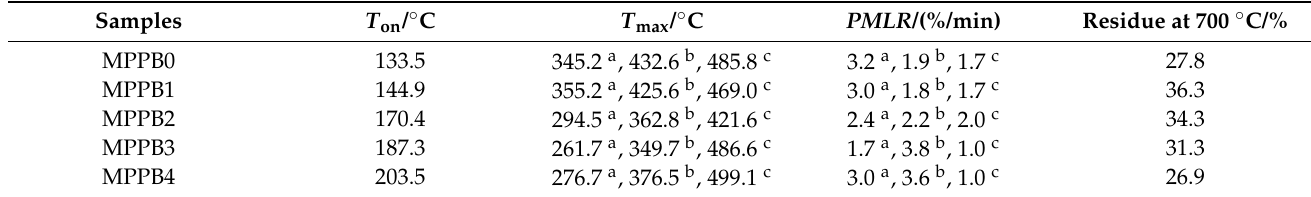
Table 3. Thermal parameters of the MPPBs coatings under nitrogen